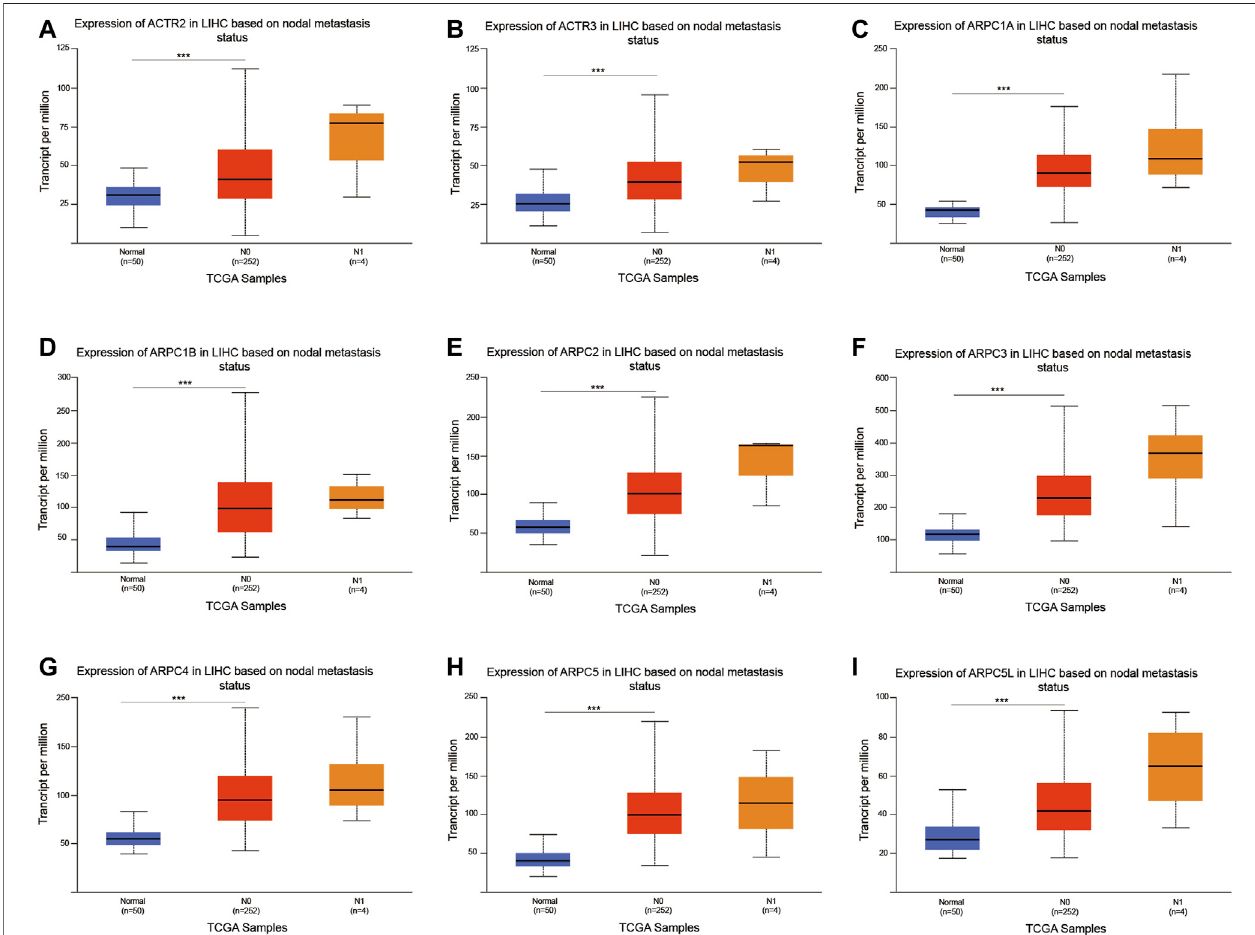
FIGURE11| AnalysisofassociationbetweenmRNAexpressionofArp2/3membersandthenodalmetastasisstatusofHCCpatients (A – I) .ThemRNAexpression of Arp2/3 members in normal individuals or in HCC patients of nodal metastasis status N0 or N1. * p < 0.05; ** p < 0.01; *** p < 0.001.